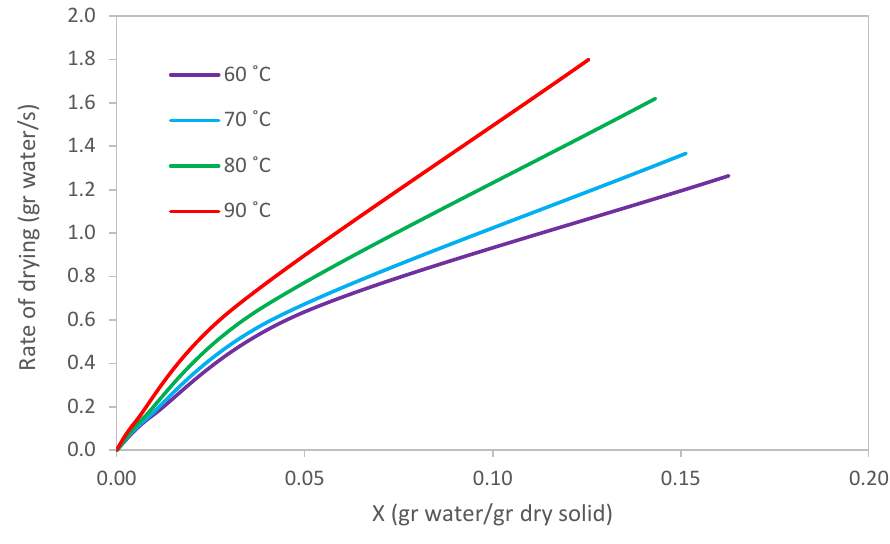
Fig. 2. Variation of drying rate versus moisture content of calcium carbonate samples at different drying